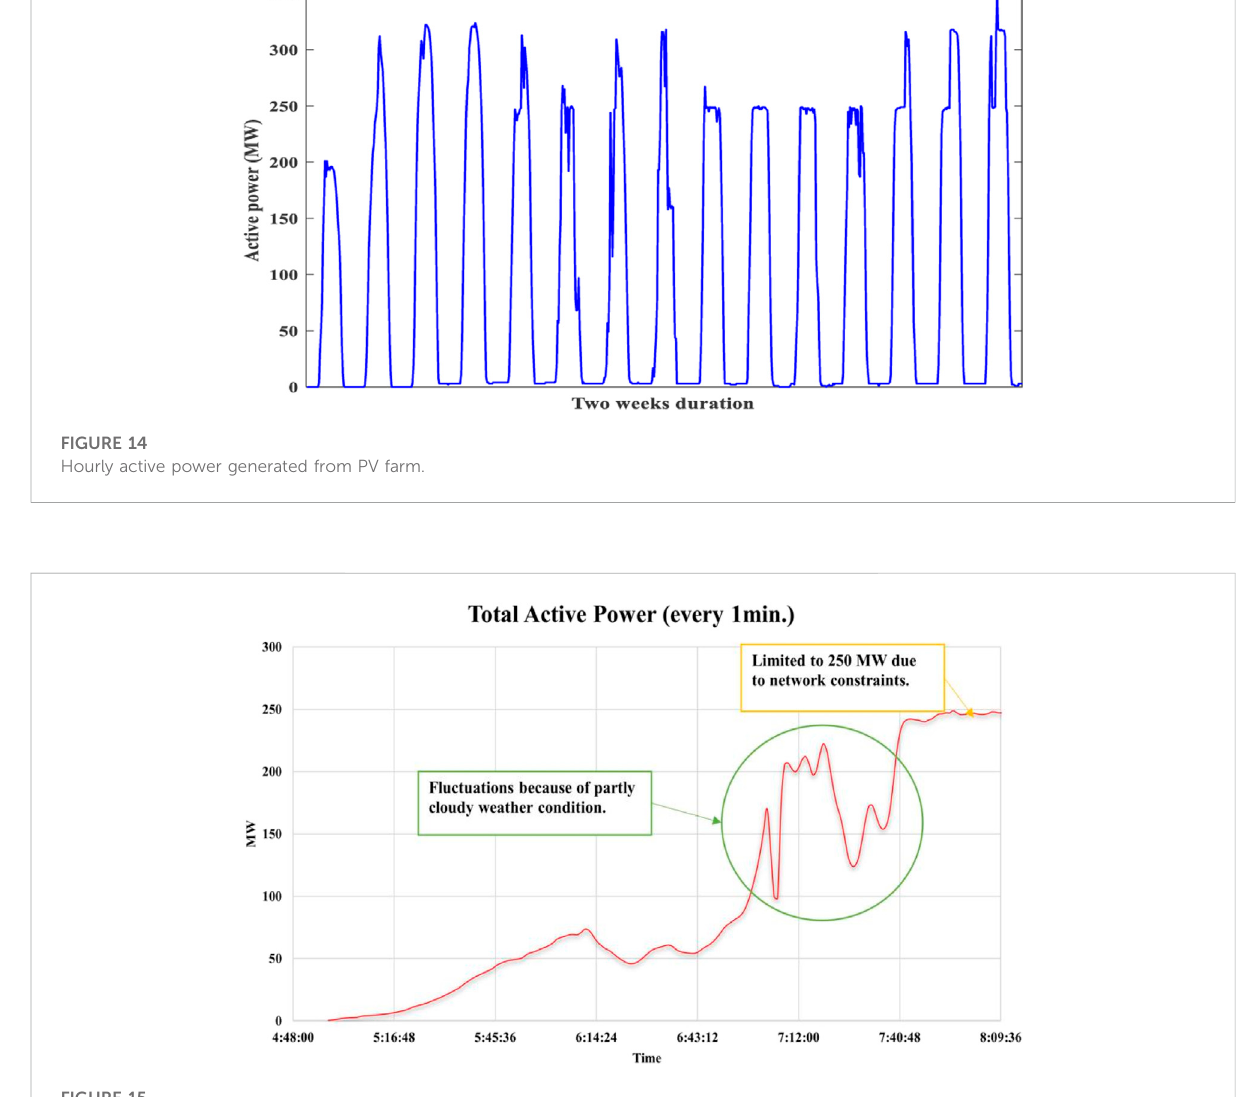
FIGURE 15 PV fl uctuation due to partly cloudy weather